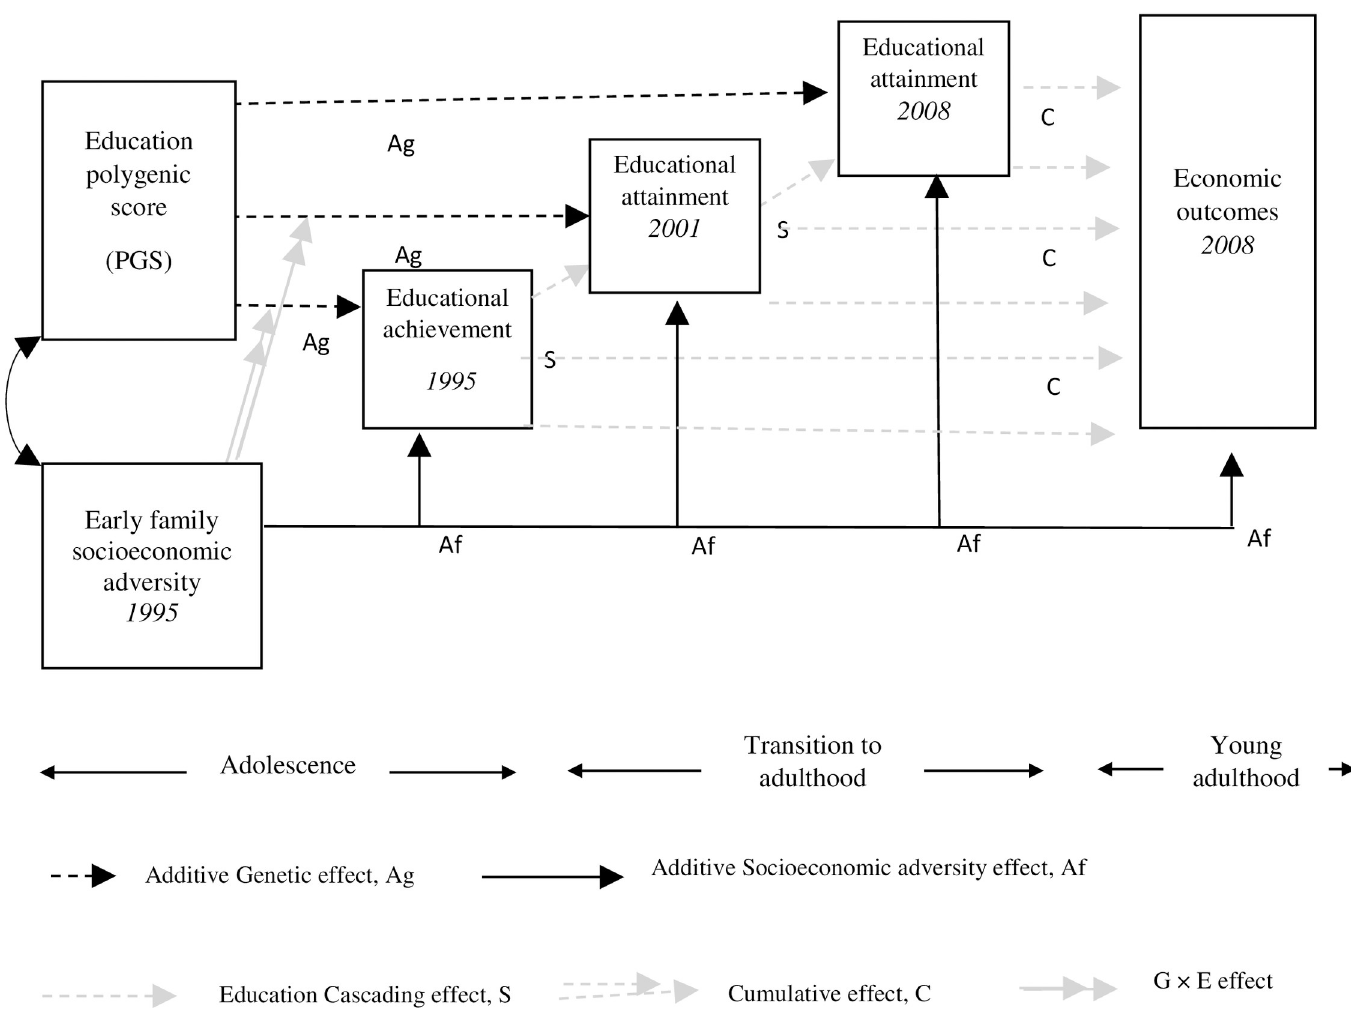
Fig 1. Early life course processes involving educational attainment leading to young adult economic outcomes.